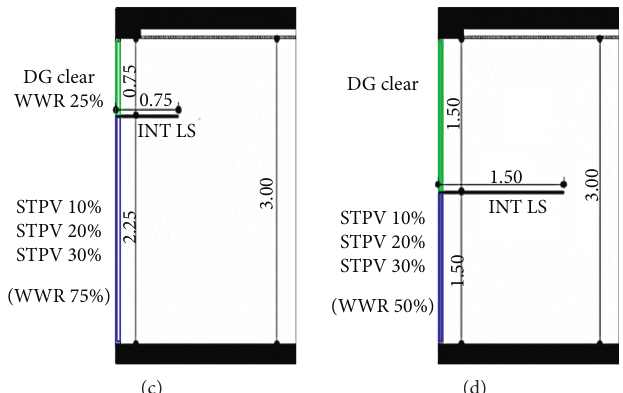
Figure 2: STPV configurations applied in each part of the simulation. (a) Reference model. (b) First Group. (c) Second Group. (d) Third Group. Table 2: Thermooptical properties of various STPV (10%, 20%, and 30% VLT) and reference glazing models. Glazing configurations